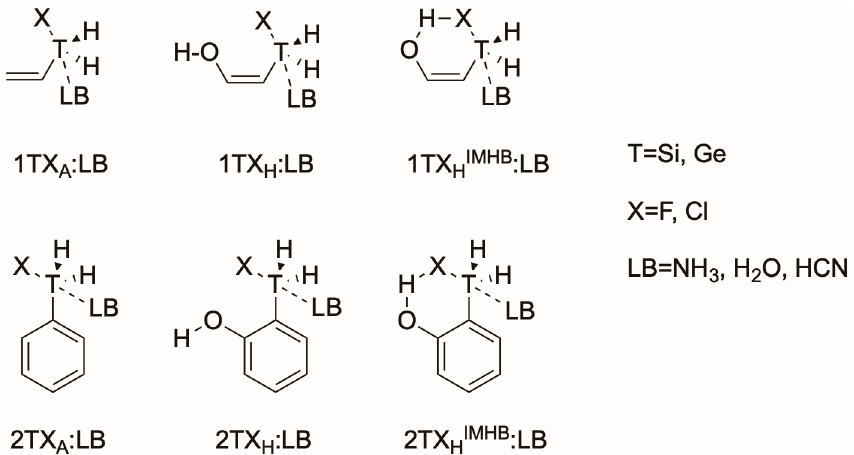
Scheme 3. Schematic representation of the nTX:LB complexes subject to study.